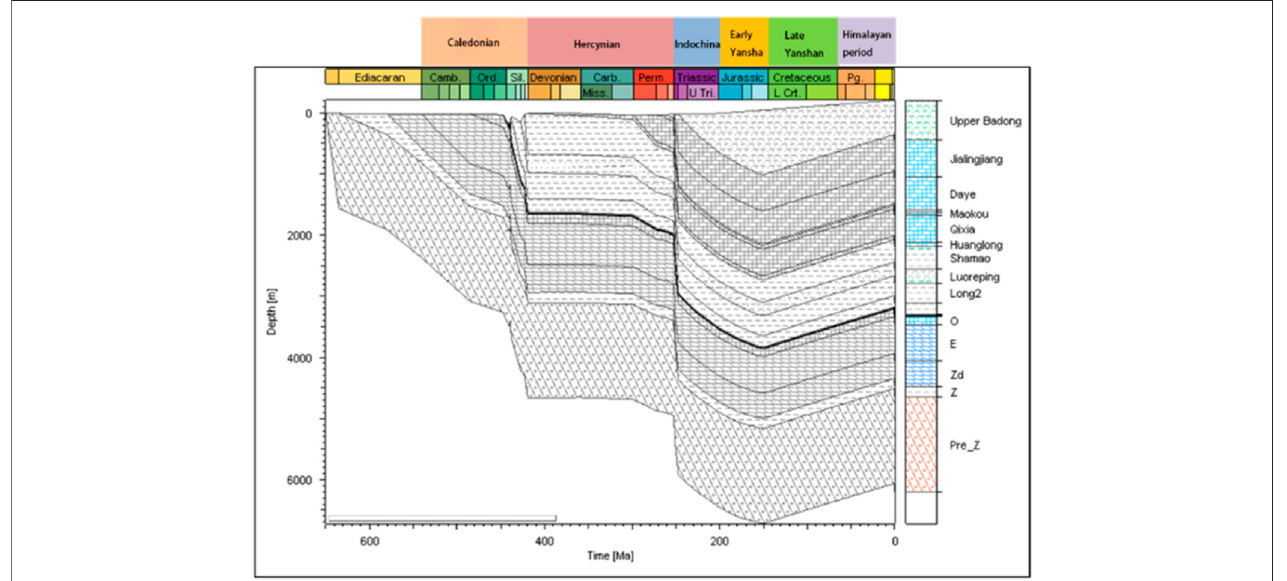
FIGURE 2 | Settlement and burial history map of Wufeng Formation-Longmaxi Formation in Well Yitan 1.